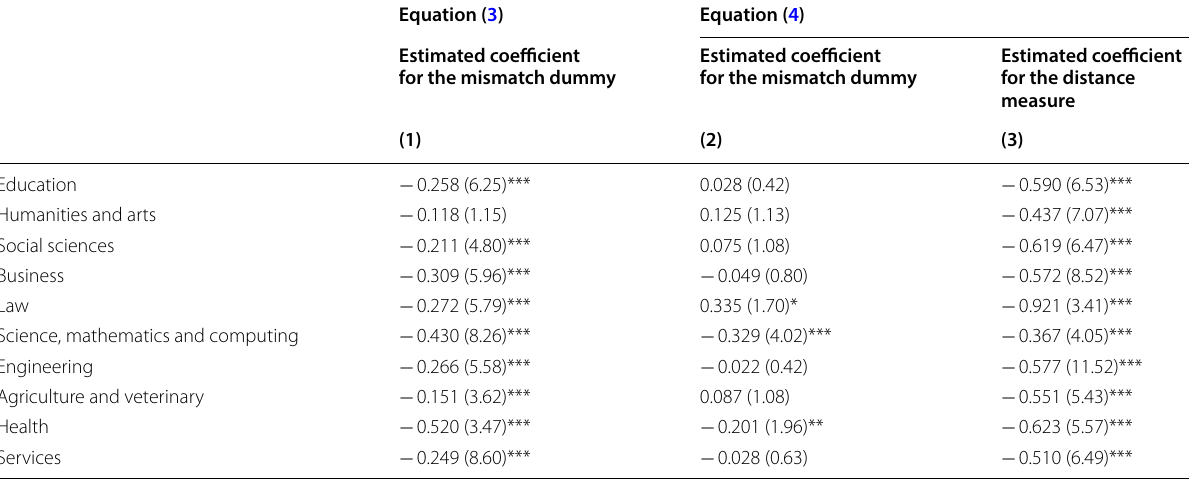
The dependent variable is the logarithm of the hourly labor earnings. All regressions include age, age squared, a dummy for female, a dummy for black and regional dummies. Regressions are estimated by OLS and t-statistics are in brackets Standard errors are clustered at the occupation-field of study level *, **, ***—indicate significance on the 10%, 5% and 1% level respectively